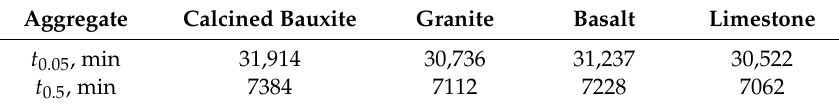
Table 11. Service life t 0.05 and half-life t 0.5 for the four aggregates.